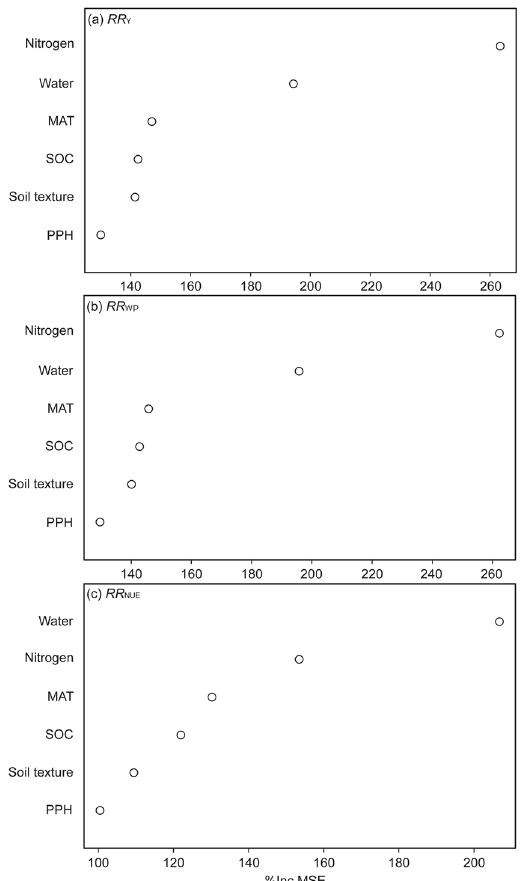
Figure 3. Increase in mean square error (IncMSE%) of variables on impacting the response ratio of ( a ) yield ( RR Y ), ( b ) water productivity ( RR WP ) and ( c ) nitrogen use efficiency ( RR NUE ). Response ratio stands for effect size between the treatment and control and is calculated using Eqs. 2–4. Higher IncMSE% means